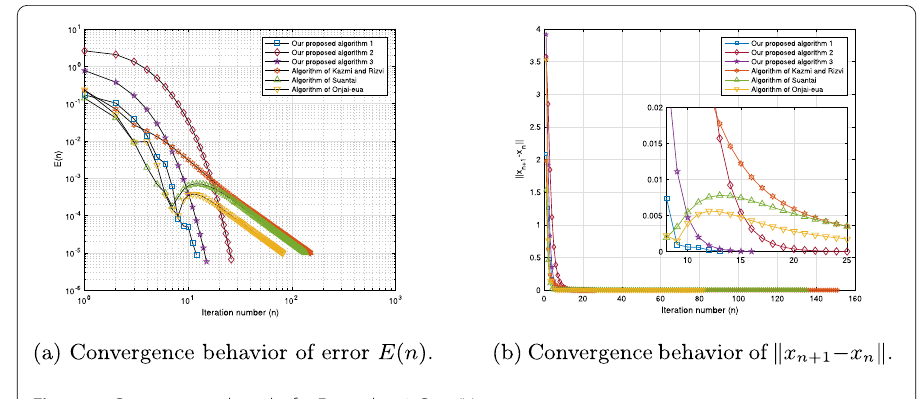
Figure 7 Computational results for Example 4.3 Case IV